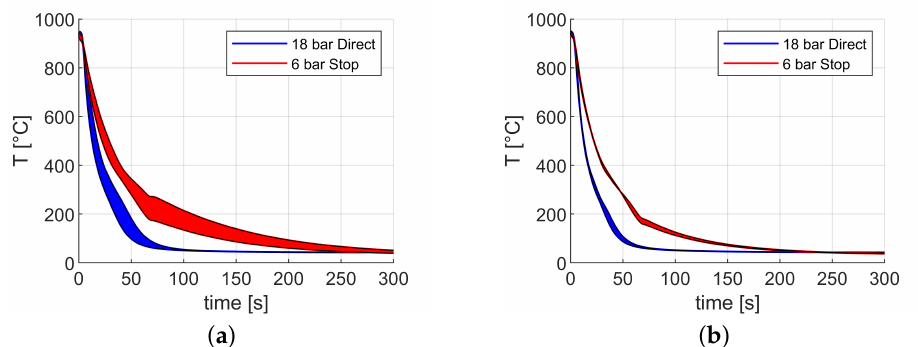
Figure 2. Temperature sequence over time for the ( a ) CT and ( b ) gear tooth tip TCs position during HPGQ for 18 bar Direct and 6 bar Stop. The temperature curves include the minimum and maxi- mum value at each temperature and the temperature range is colored in red (6 bar Stop) and blue (18 bar